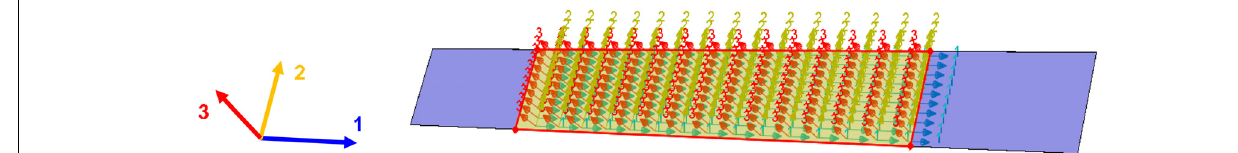
FIGURE 6 | Orthotropic lamina behavior for the textile fibers.